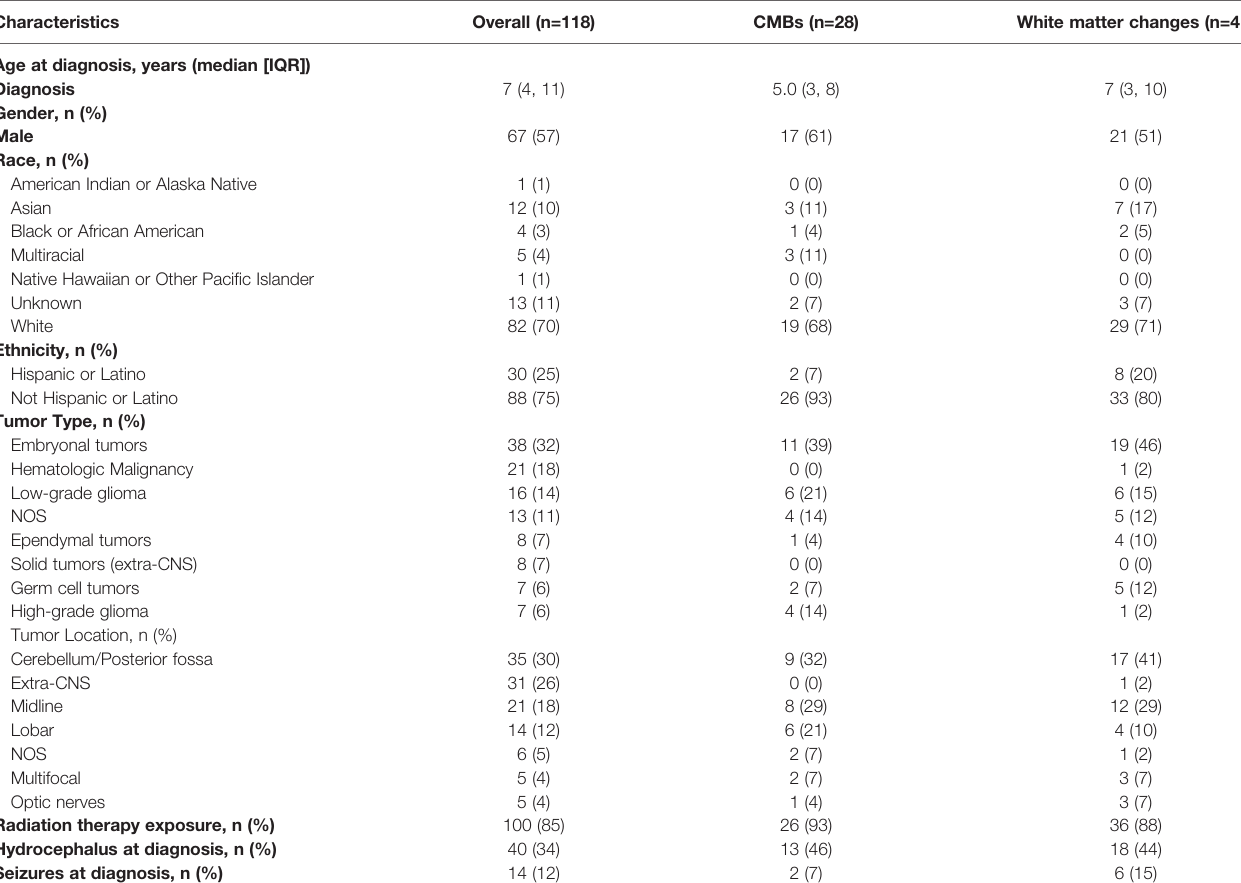
TABLE 1 | Summary of patient demographics, tumor characteristics, and baseline clinical symptoms across each subcohort by column.